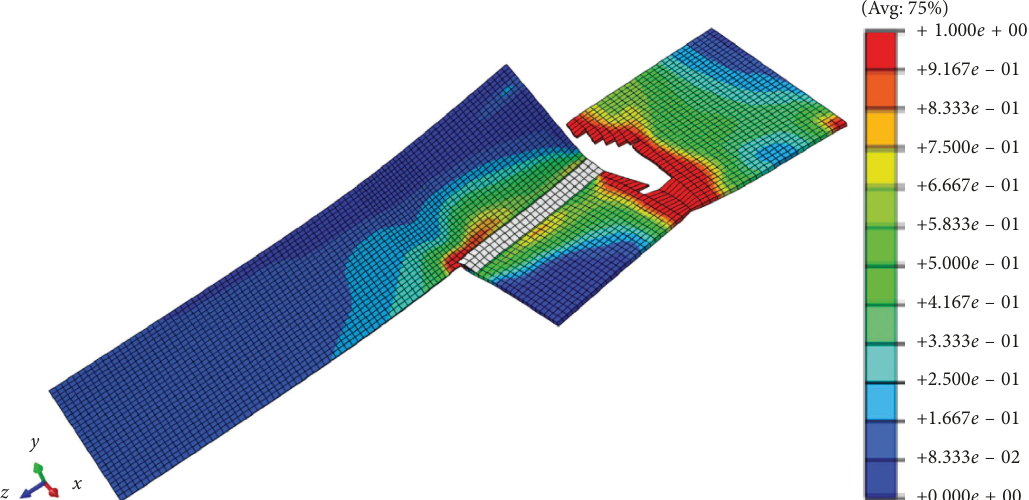
Figure 13: The rupture of the gusset plate in the finite element